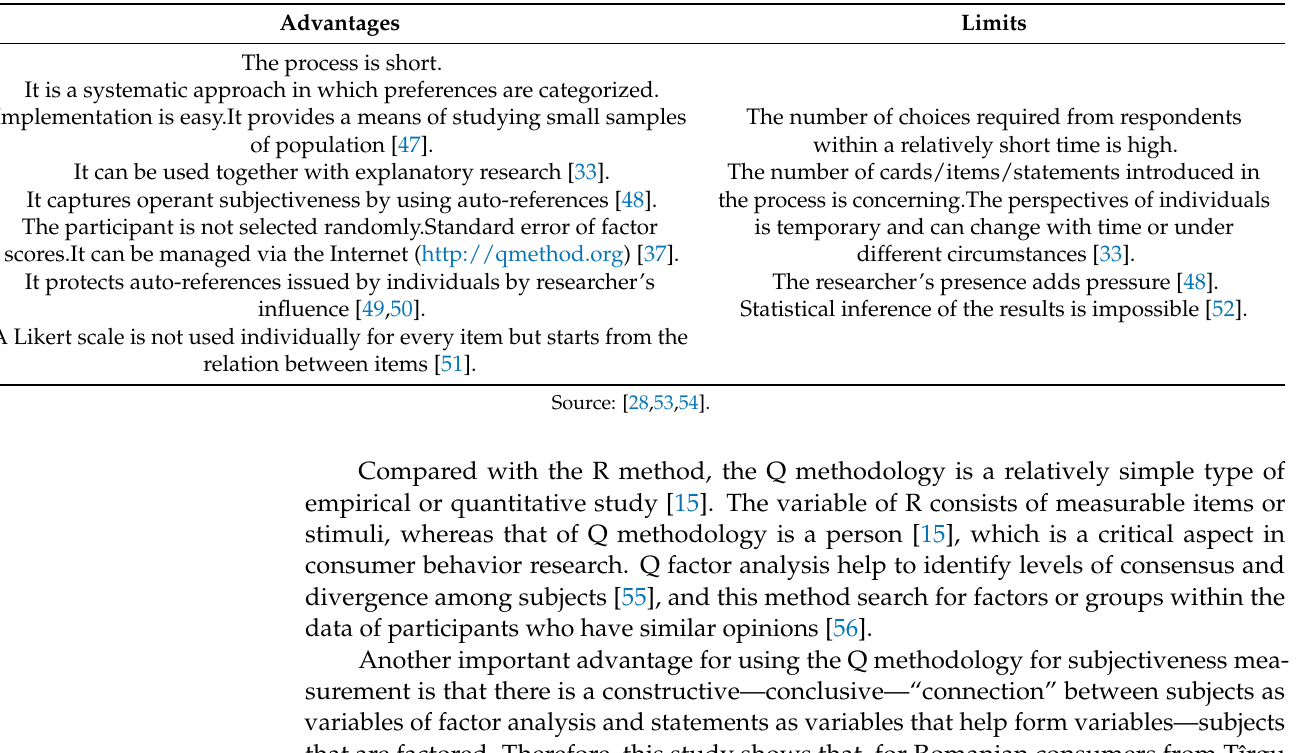
Table 7. Advantages and disadvantages of using of Q factor